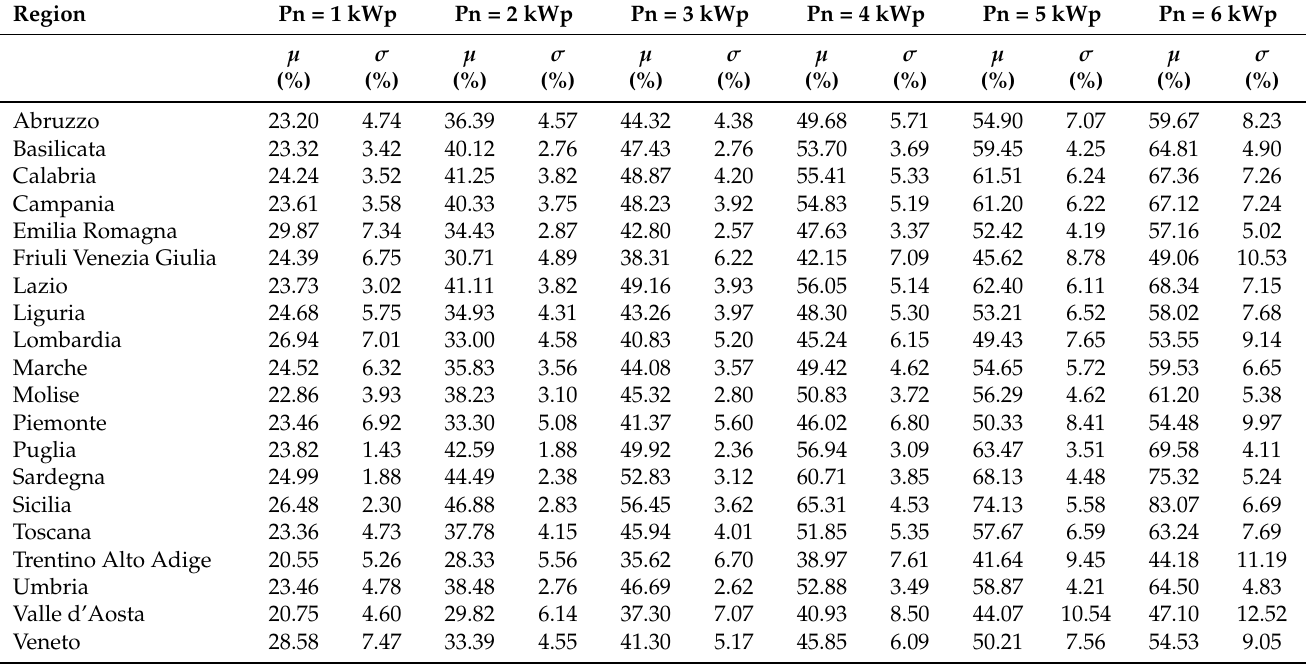
Table 6. Cost saving for E L = 2700 kWh without